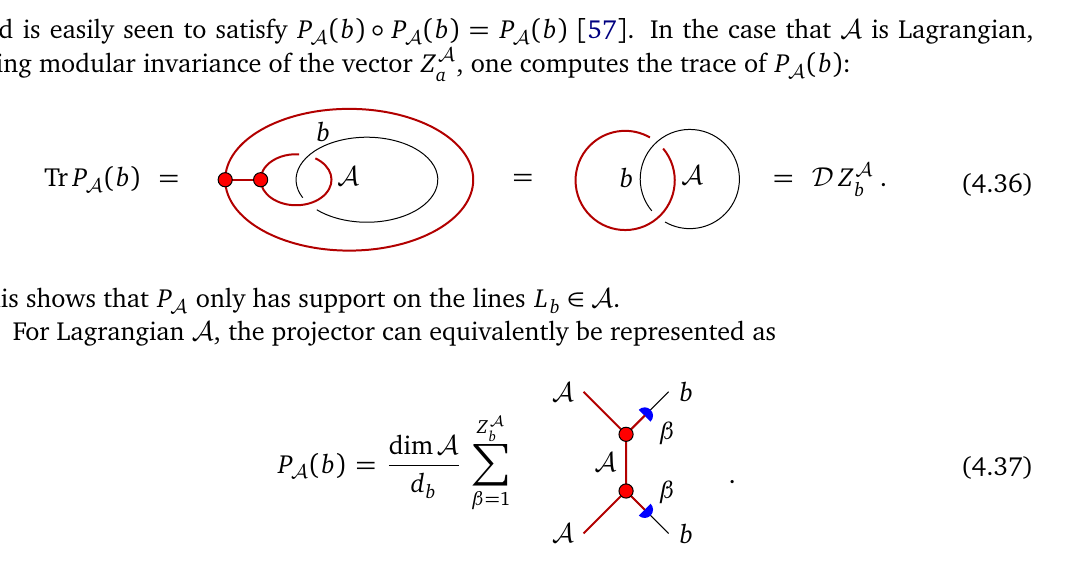
Figure 6: Left: orthogonality of A -modules. The index κ labels different mod- ules. Right: this relation is obtained from the left by setting M κ = M κ ′ = A and ρ = m , composing with the projections γ below and δ above, and then summing M over c , γ , d , δ